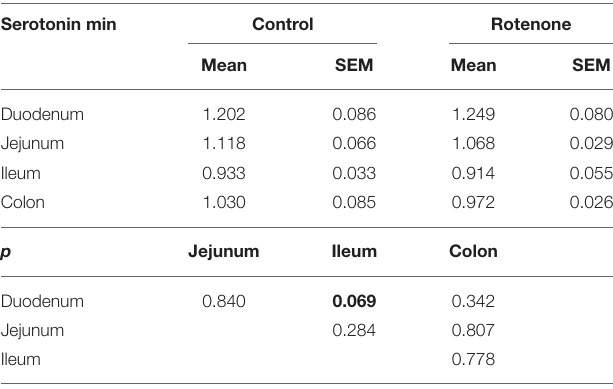
TABLE 7 | Shows the mean values (mean) and the standard error of the mean (SEM) for maximal tension exerted by serotonin (S) when added in the presence of AT and G.